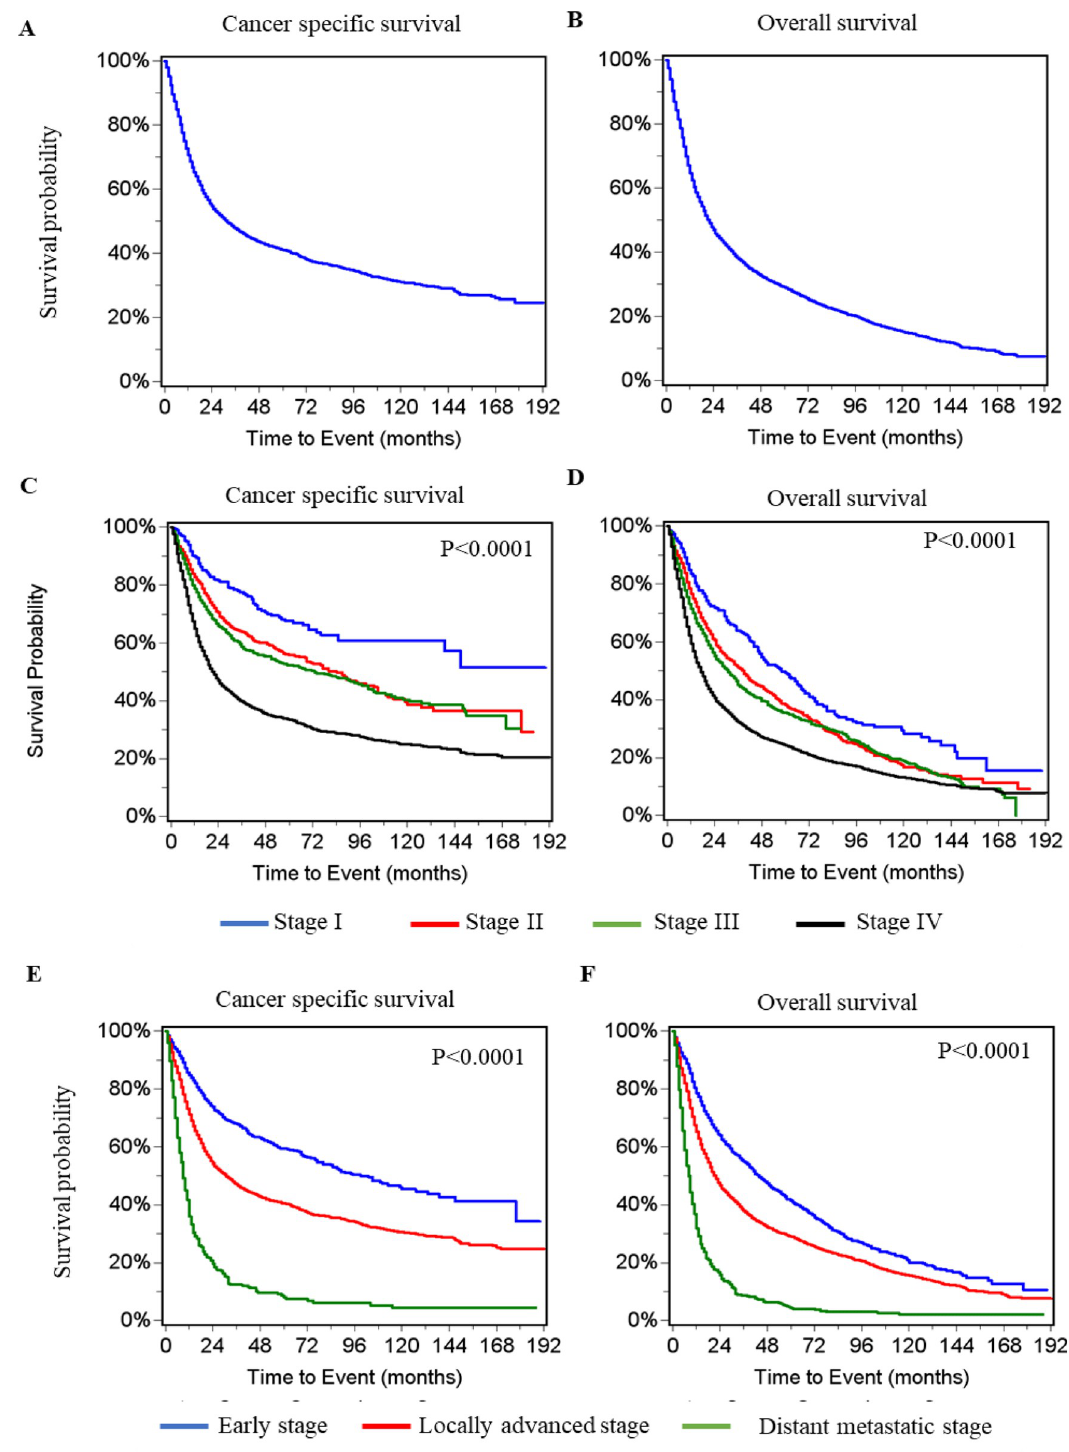
Fig 2. Kaplan–Meier survival curves in patients with hypopharyngeal squamous cell carcinoma (HPSCC). Cancer specific survival curves in all patients ( A ), in individual stages ( C ) and in early (I/II), locally advanced (III-IVb) and distant metastatic (IVc) stages ( E ). Overall survival curves in all patients ( B ), in individual stages ( D ) and in early (I/II), locally advanced (III-IVb) and distant metastatic (IVc) stages ( F ).